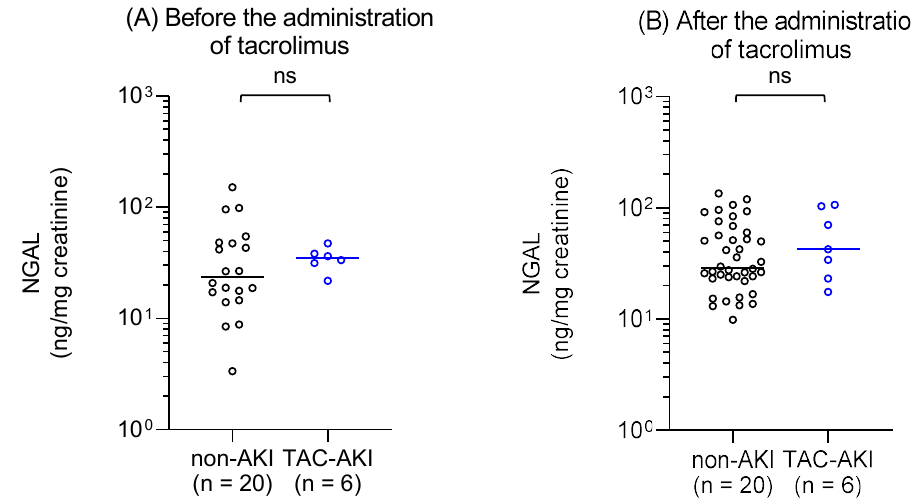
Figure 1. Urinary levels of neutrophil gelatinase-associated lipocalin (NGAL) in the non-AKI and TAC–AKI groups before and after the administration of tacrolimus. ( A ) Urinary samples were collected on Postoperative Day 1 immediately before the administration of tacrolimus. There were 20 measurements (20 subjects) in the non-AKI group and six measurements (six subjects) in the TAC–AKI group. ( B ) Urinary samples were collected during tacrolimus therapy (either Postoperative Day 7 or 14). There were 40 measurements in the non-AKI group (20 subjects) and seven measurements in the TAC–AKI group (six subjects).